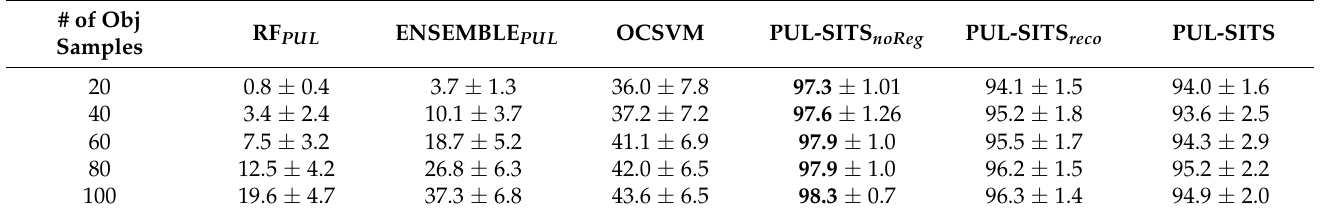
Table 12. Performances in terms of the Specificity of the different competing strategies when the land cover class of interest (the positive class) is Forest .